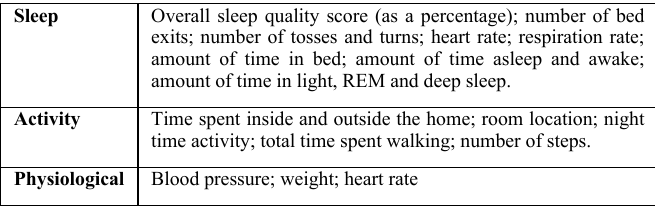
S ENSOR - DERIVED METRICS PRESENTED TO PARTICIPANTS